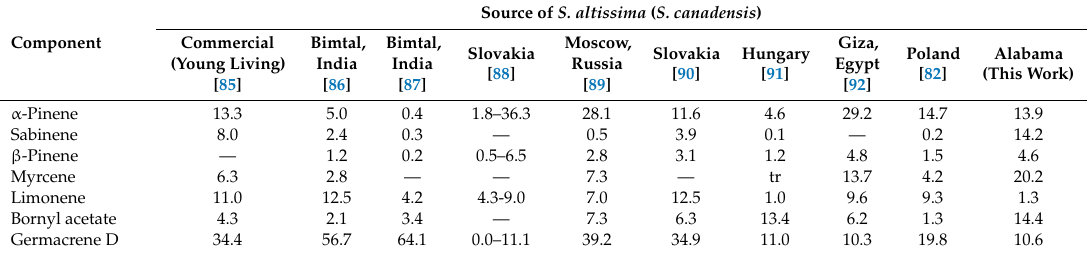
Table 10. Comparison of the major components in Solidago altissima (syn. S. canadensis ) essential oils.